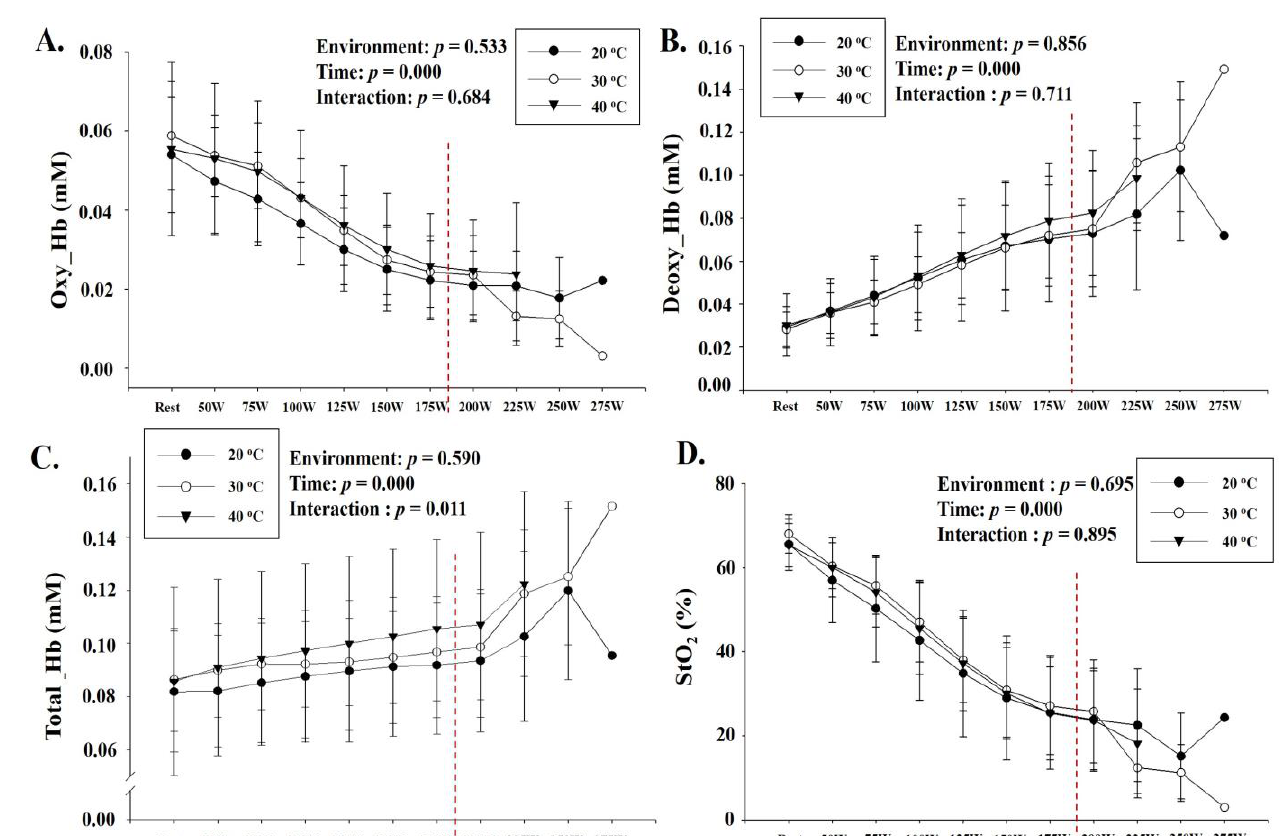
Figure 5. Changes in skeletal muscle oxygen profiles at rest and during GXT (mean ± standard deviation): ( A ) change in Oxy_Hb, ( B ) change in Deoxy_Hb, ( C ) change in Total_Hb, and ( D ) change in S t O 2 are shown. GXT: graded exercise test; Oxy_Hb: oxygenated hemoglobin; Deoxy_Hb: deoxygenated hemoglobin; Total_Hb: total hemoglobin; S t O 2 : tissue oxygen saturation.